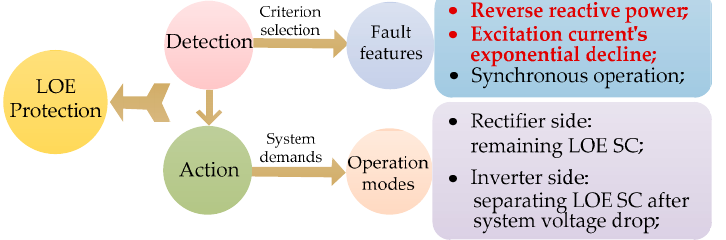
Figure 10. Preliminary suggestions for SC’s LOE Figure 10 . Preliminary suggestions for SC’s LOE protection. 30